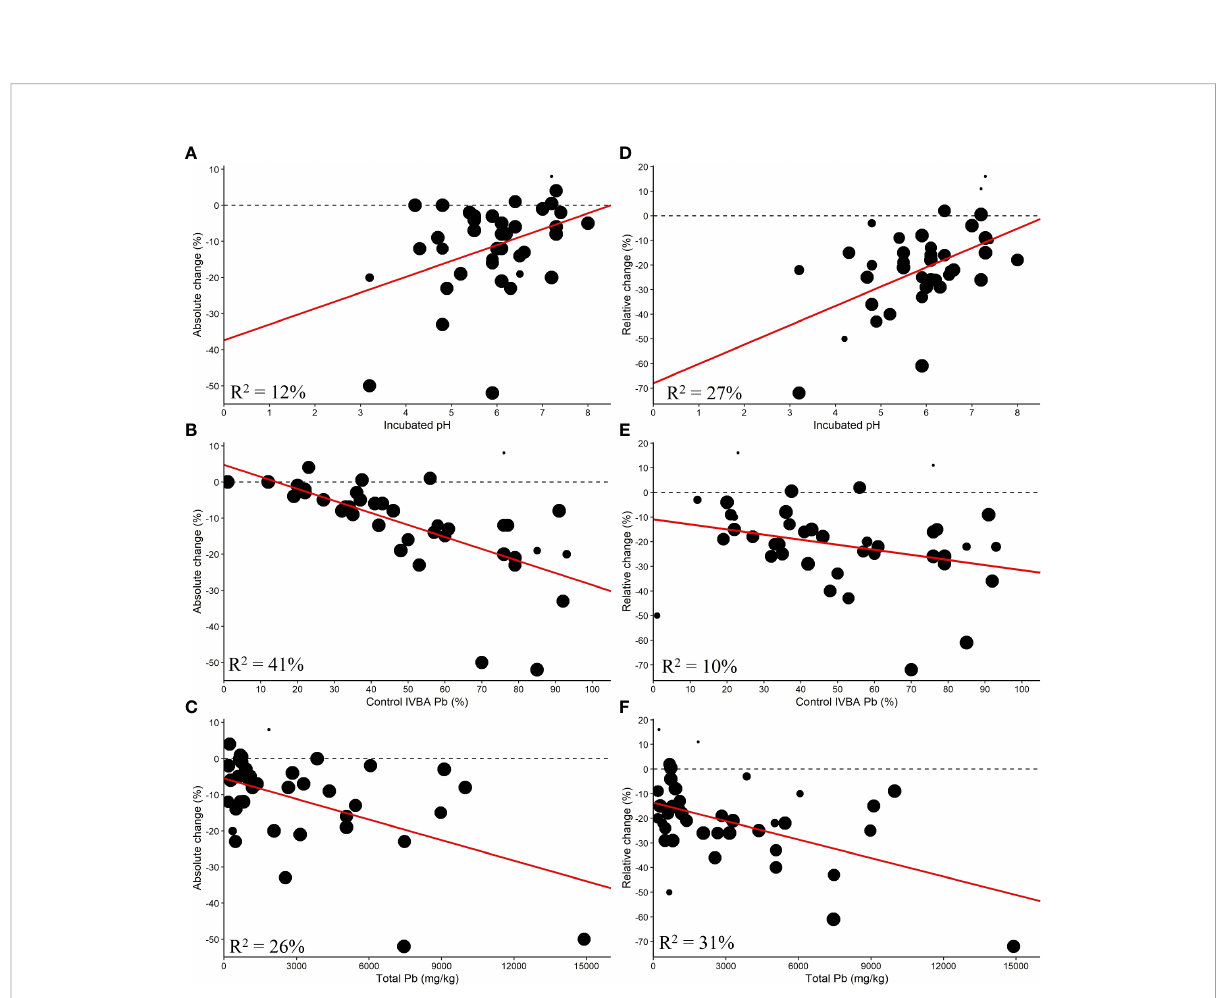
FIGURE 6 Single linear meta-regression for AC by (A) incubated pH, (B) control IVBA Pb, and (C) total Pb and RC by (D) incubated pH, (E) control IVBA Pb, and (F) total Pb.